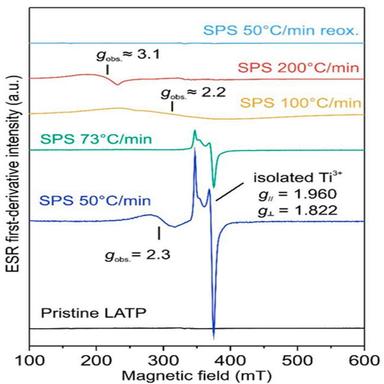
Low temperature (30 K) X-band ESR powder spectra obtained for pristine LATP, sintered samples (50 ◦C/min, 73 ◦C/min, 100 ◦C/min and 200 ◦C/min) and re-oxidized sample (reox.). All the spectra are normalised according to sample mass and all the spectroscopic parameters that can influence the ESR first-derivative curve intensity.